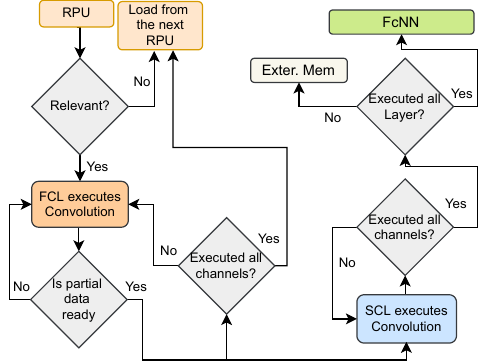
Figure 3. Proposed HARP architecture for CNN integration at the image sensor. The sensor populates the RPUs in parallel. The APL identifies the relevant regions and the ICL computes convolution on the relevant regions.